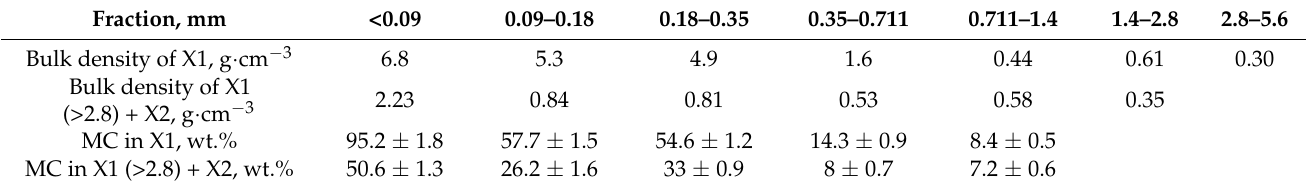
Table 3. Bulk densities and MC of one-step (X1) and double-step (X1 (>2.8) + X2) milled PCB